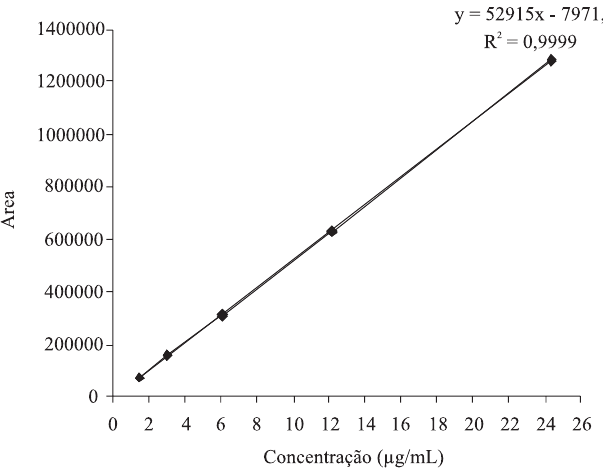
FIGURA 3 - Curva analítica da galocatequina. Valor mínimo do coeficiente de correlação (“R 2” ) estipulado pela RE nº 899: